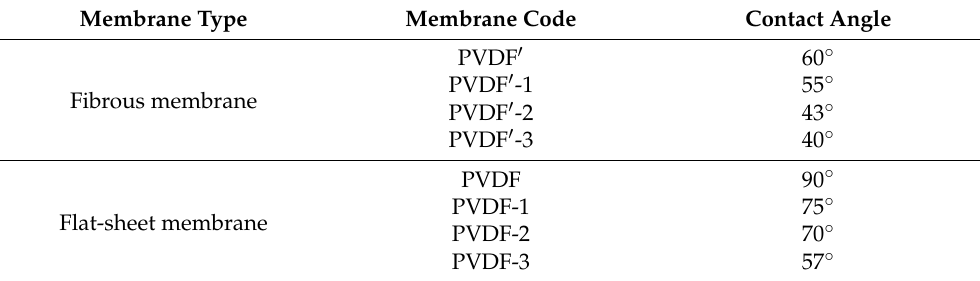
Table 2. Results of static contact angle measurements on PVDF electrospun fibrous membranes compared to the same composition of flat-sheet